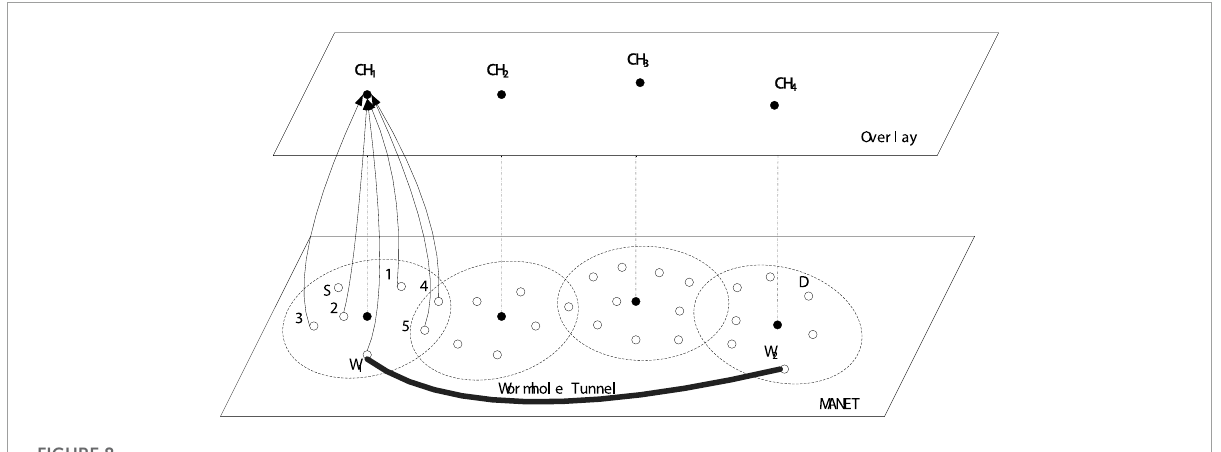
FIGURE 8 Clusterheads monitor the corresponding